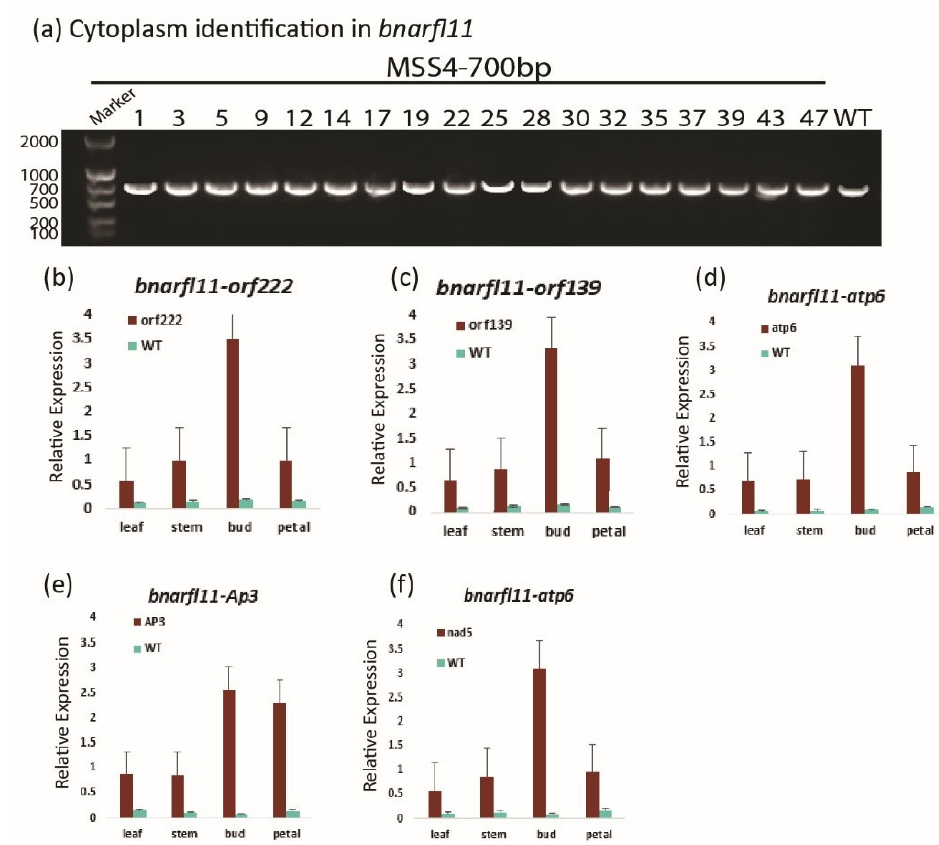
Figure 10. RT-PCR and qRT-PCR of bnarfl11 plants. ( a ) RT-PCR analysis of nap-CMS cytoplasm in bnarfl11 plants. For RT-PCR, total DNA was extracted from the Cas9 transgenic line, and the W.T. leaves. ( b – f ) qRT-PCR analysis of CMS-causing genes in bnarfl11 plants. For qRT-PCR analysis, total RNA was extracted from leaves, stems, buds, and petals of the Cas9 transgenic line. Values represent the mean and standard deviation. Error bars indicate the standard deviation among triplicate experiments.